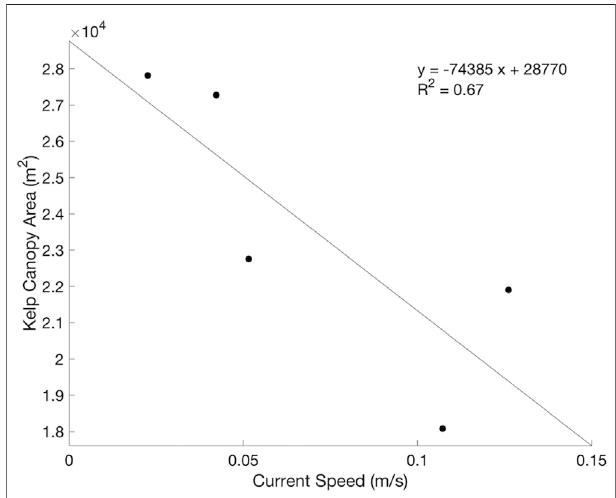
FIGURE11| Regressionanalysisbetweenkelpcanopyareaandcurrent speed during the Arroyo Quemado current surveys.